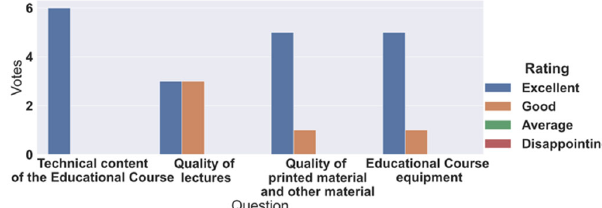
Figure 11 Survey results concerning content and quality of the lectures